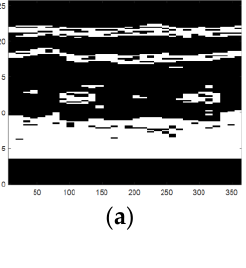
Figure 14. The defect images processed by the three-threshold maximum inter-class variance method: ( a ) small crack, ( b ) transverse crack, ( c ) hole defect, and ( d ) chapped defect.